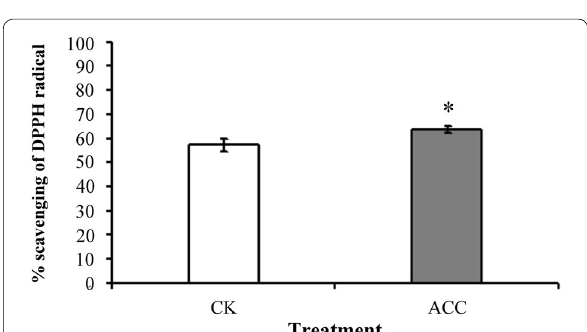
Fig. 4 DPPH radical scavenging activity in tea seedlings on modula‑ tion of ethylene signaling. The scavenging ratios of DPPH radicals were determined from the detached tea seedling samples after treat‑ ment with the control (CK) or 100 μM ACC for 5 days. Data points are mean SD of three biologically independent experiments. Asterisks ± indicate significant differences from the control sample (P <